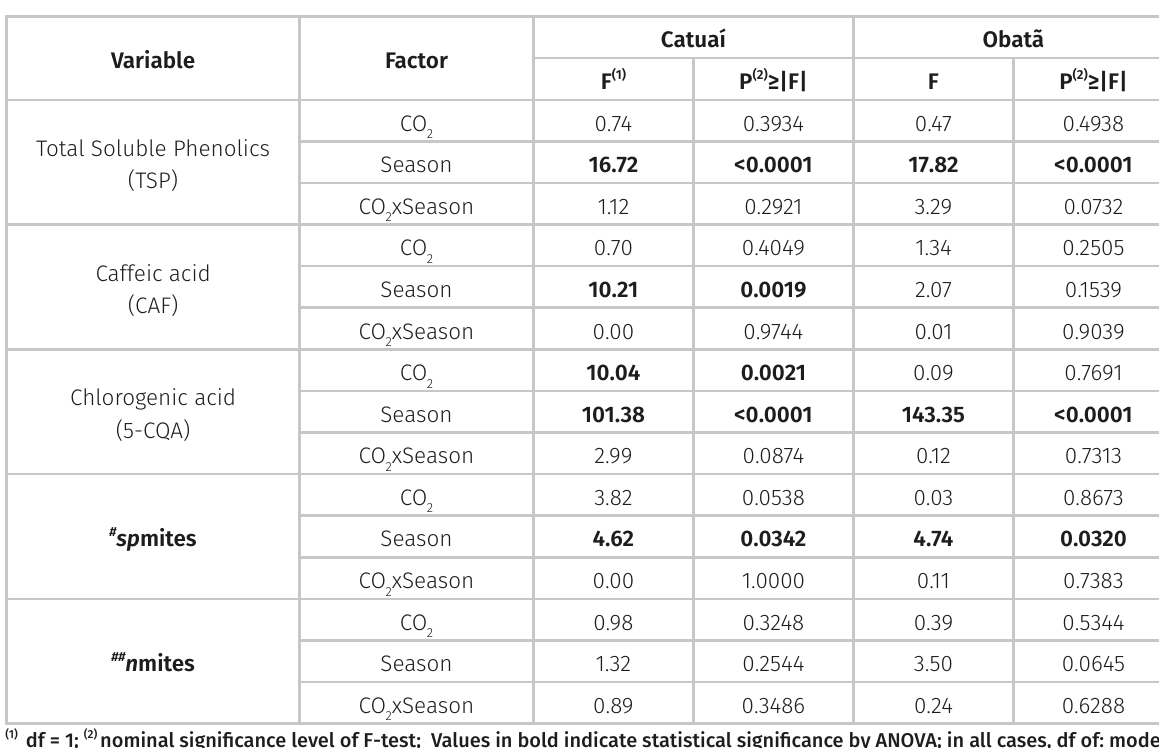
] (elevated/ambient), in two seasons (dry/rainy) under factorial 2